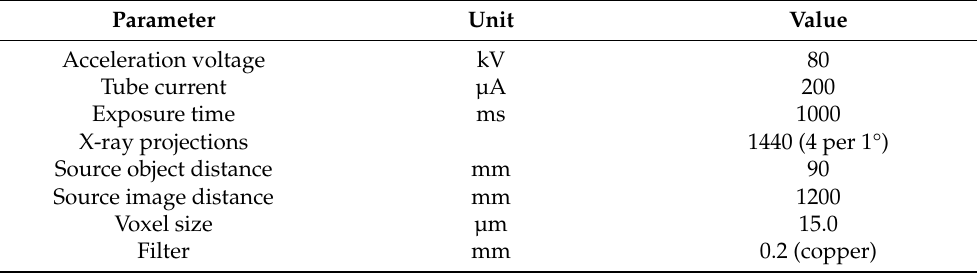
Table 3. Test specification for compaction specimens for